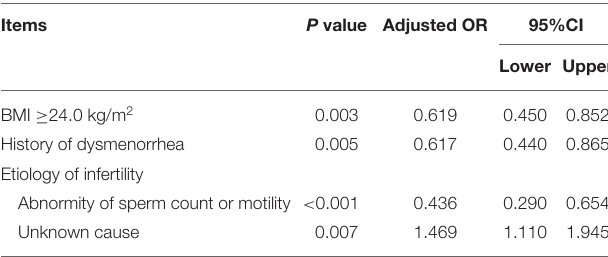
TABLE 2 | Pregnancy rate among patients with different clinical characteristics. TABLE 3 | Multivariate logistic regression analysis for